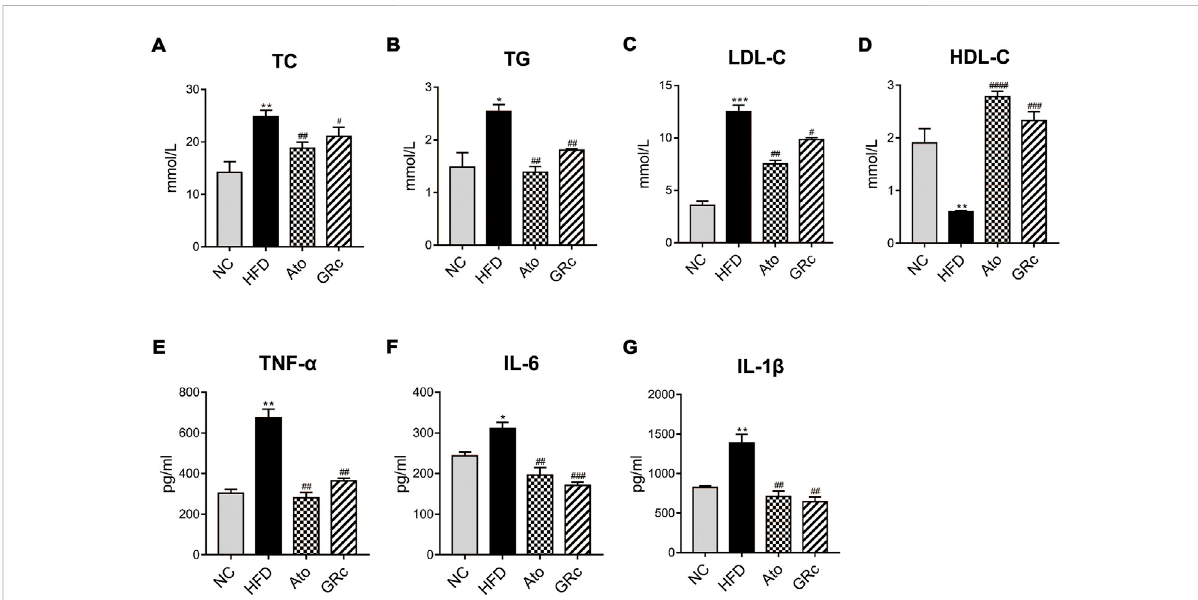
FIGURE 3 GRcregulatedlipid and systemicin fl ammatorycytokinesinHFD-inducedApoE − / − mice. (A – D) Levels ofserum lipids(TC, TG, LDL-C, andHDL- C) per group. (E – G) Levels of in fl ammatory cytokines (TNF- α , IL-6, and IL-1 β ) per group. The data are expressed as means ± SEM. * p < 0.05, ** p < 0.01, and *** p < 0.001 vs. NC; # p < 0.05, ## p < 0.01, and ### p < 0.001 vs. HFD. NC, normal control; HFD, high-fat diet; Ato, atorvastatin; GRc, ginsenoside